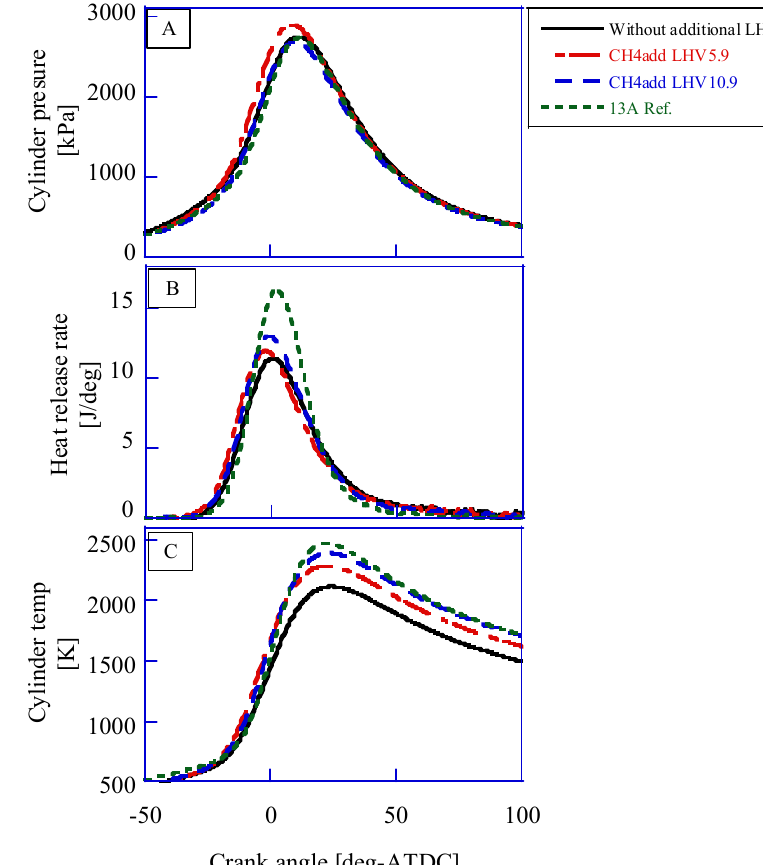
Figure 5. Time histories of cylinder pressure and derivatives (CH 4 addition). Though the difference between the 13A case and the bio-syngas case is large, the additional cases do not show so much difference in the heat release rate and cylinder temperature. ( A ) the cylinder pressure, ( B ) heat release rate (the Supplementary Materials shows the definitions.), ( C ) cylinder temperature (the Supplementary Materials shows the definitions.).